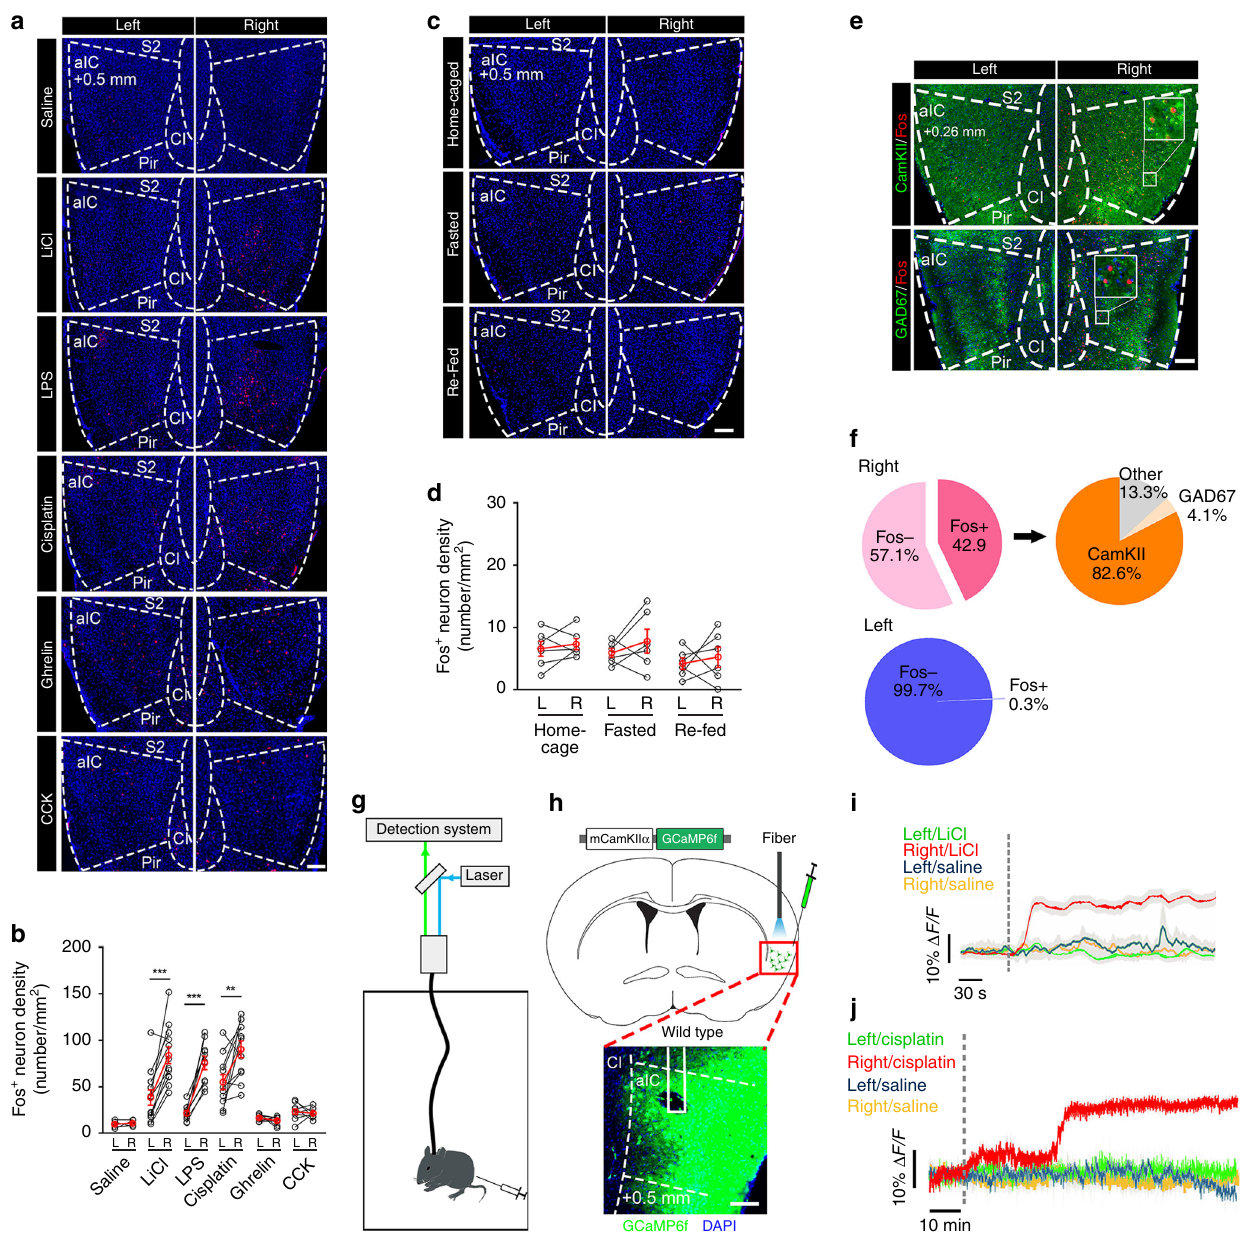
Fig. 1 CamKII + neurons in the right aIC are activated by aversive visceral stimuli. a , b Representative histology a and quanti fi cation b of Fos-like immunoreactivity in the left and the right aIC after intraperitoneal injection of saline ( n = 16 mice), LiCl (150 mg/kg, n = 21 mice), cisplatin (4 mg/kg, n = 11 mice), LPS (0.1 mg/kg, n = 14 mice), Ghrelin (1 mg/kg, n = 6 mice), or CCK (5 μ g/kg, n = 6 mice). Two-tailed unpaired t test, scale bar, 250 μ m. c , d Representative histology c and quanti fi cation d of Fos-like immunoreactivity in the left and the right aIC in fed or 24-h fasted mice with or without 3-h refeeding ( n = 6 mice per group. Two-tailed unpaired t test). Scale bar, 250 μ m. e , f Co-expression e of CamKII or GAD67 (green) with Fos (red) in the right or left aIC injection with LiCl and quanti fi cation f . n = 6 mice per group. Scale bar, 100 μ m. g Schema of the fi ber photometry approach. h Image of GCaMP6f expression in the right aIC CamKII , with the fi ber track above. Scale bar, 500 μ m. i , j Representative mean GCaMP6f fl uorescence responses of both sides of the aIC CamKII neurons by injection of Saline, LiCl, or Cisplatin. i.p. intraperitoneal. n = 4 mice per group. For b and d , red line represents averaged data. ** P < 0.01; *** P < 0.005. Data are presented as means ± SEM. Source data are provided as a Source Data fi Activating the right-side aIC CamKII neurons impairs feeding . showed that action potentials of ChR2-expressing aIC CamKII neurons were triggered by 473-nm light pulses (Fig. 2b). We next To explore whether the CamKII + neurons in the caudal segment of the right aIC mediate feeding behavior, we injected Cre- performed a time-resolved analysis of feeding in mice that were dependent AAV containing a double fl oxed inverted orientation deprived of food for 24 h (Fig. 2c). Photoactivation of the right (DIO) excitatory optogenetic receptor construct (AAV8-DIO- aIC CamKII neurons at 20 Hz signi fi cantly decreased the amount of hChR2(H134R)-eGFP) into the caudal segment of the right aIC food intake (two-tailed unpaired t test , t 17 = 2.385, P = 0.029) of Camk2a-Cre transgenic mice (Fig. 2a, Supplementary Fig. 5a). and the percentage of time spent feeding (feeding time was Whole-cell patch-clamp recordings in the acute brain slices determined as the time the mice successfully accomplished